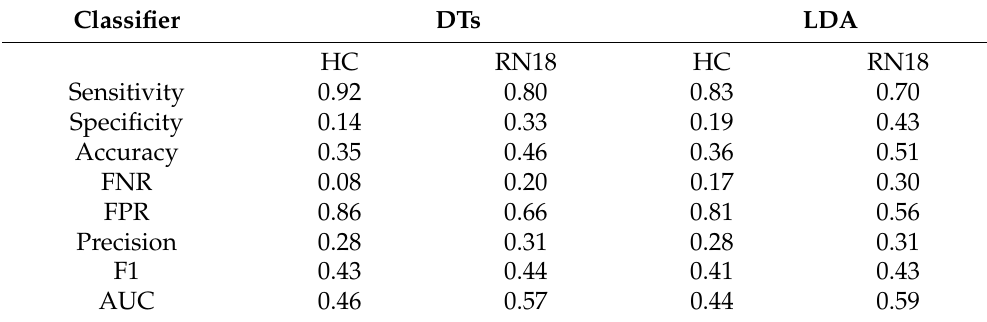
Table 5. Results with the hotBSI trained with decision trees and linear discriminant analysis.